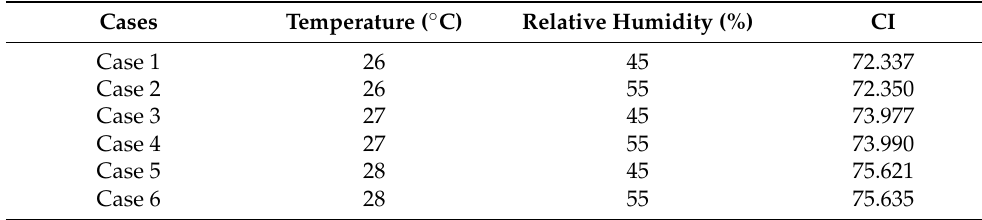
Table 5. The corresponding parameters of studied cases.